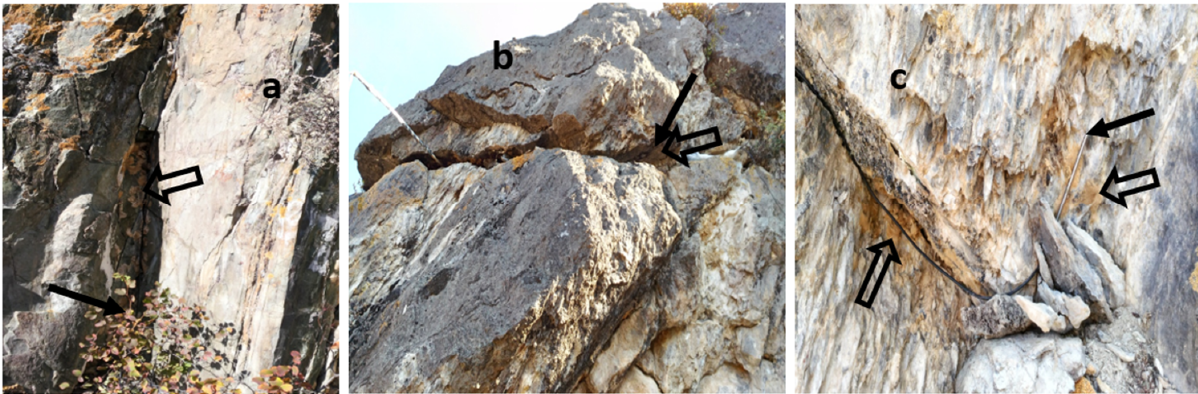
Figure 1. Sites where temperature sensors were installed (51.33° N, 84.74° E, 808 m above sea level): ( a )—a recess in the rock (“recess”), ( b )—a slit under the stone at a depth of 20 cm from the